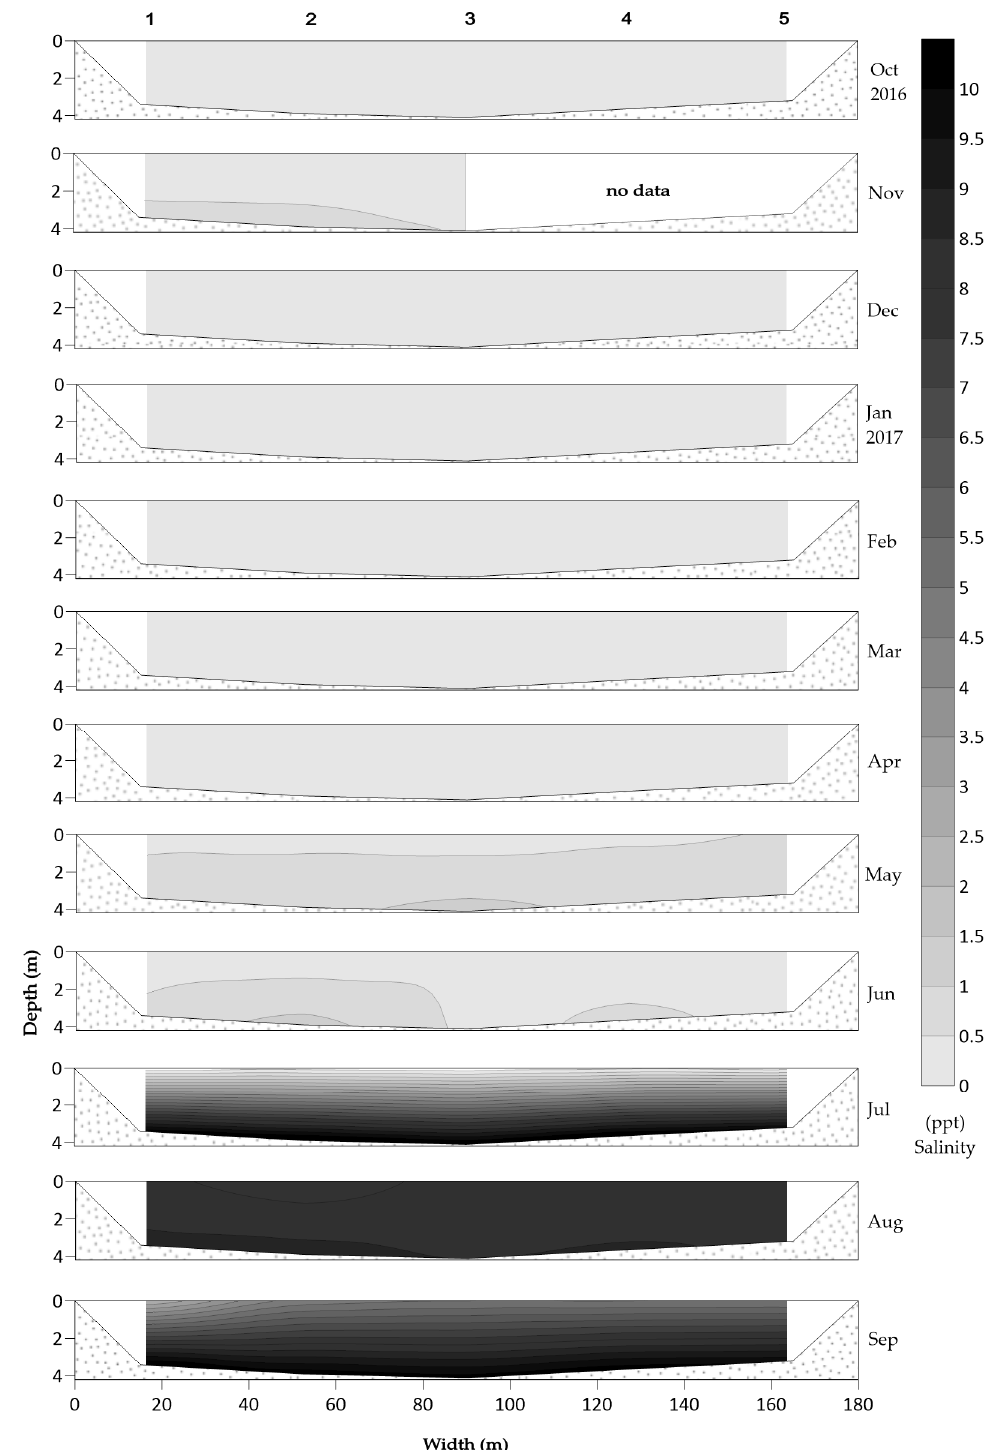
Figure 5. The cross-section of salinity contour data at BH2.